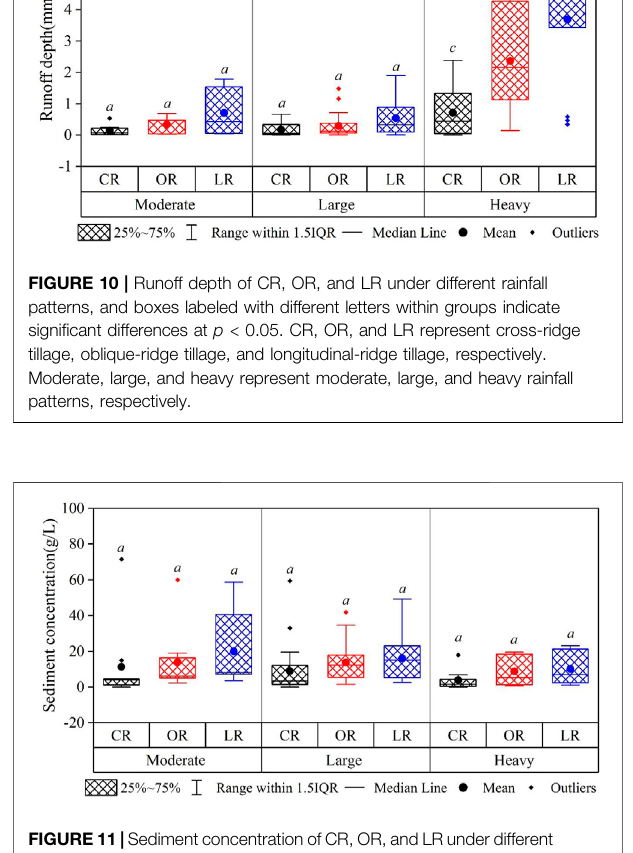
FIGURE11 | Sedimentconcentration ofCR, OR, and LR under different rainfall patterns, and boxes labeled with different letters within groups indicate signi fi cant differences at p < 0.05. CR, OR, and LR represent cross-ridge tillage, oblique-ridge tillage, and longitudinal-ridge tillage, respectively. Moderate, large, and heavy represent moderate, large, and heavy rainfall patterns, respectively.